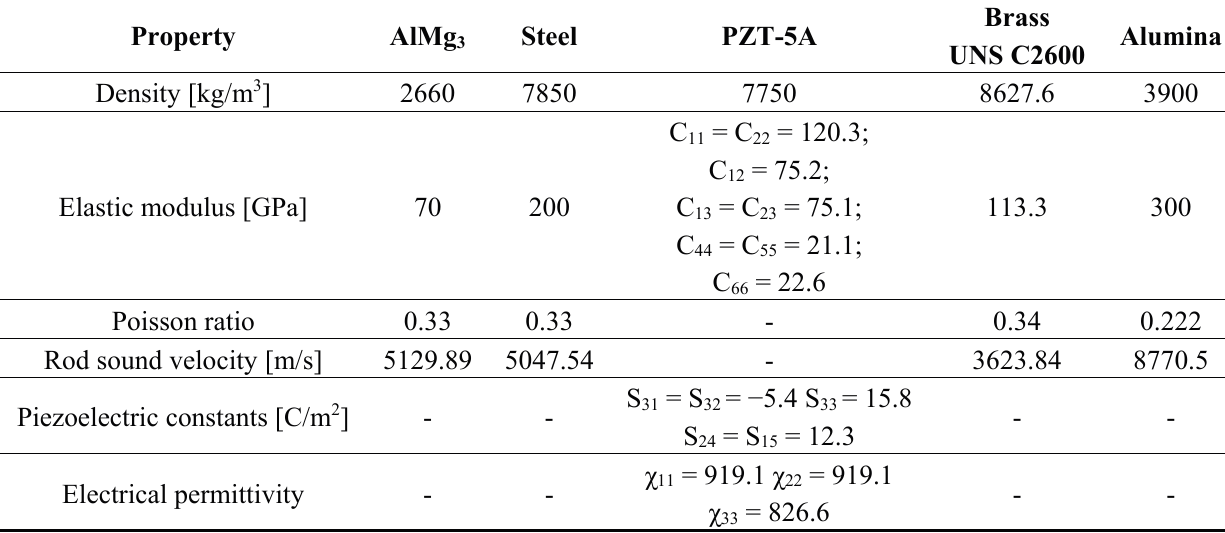
Table 1. Set of material constants used in simulation.